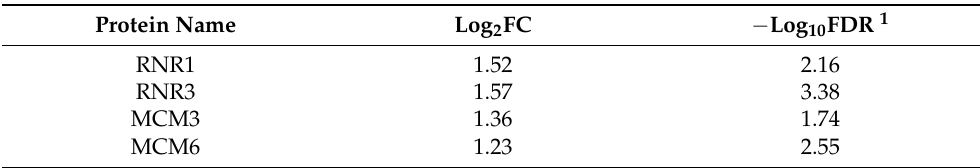
Table 2. DNA replication-related proteins that are upregulated in the YPL strain compared to the WT